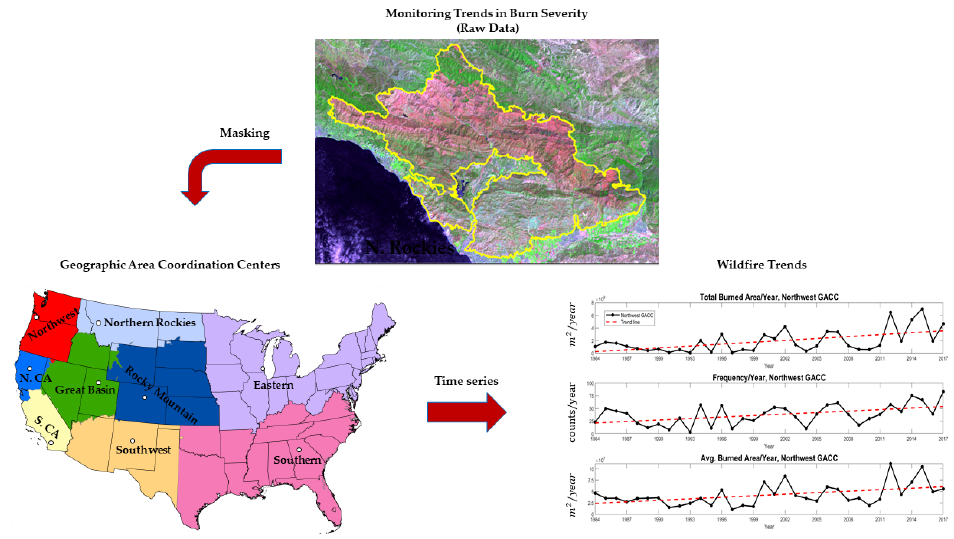
Figure 2. The general process of this study to obtain wildfire time series over CONUS from 1984 to 2017. Each wildfire time series is fitted with a linear trend using linear regression methods and tested for significance under the Mann–Kendall test.